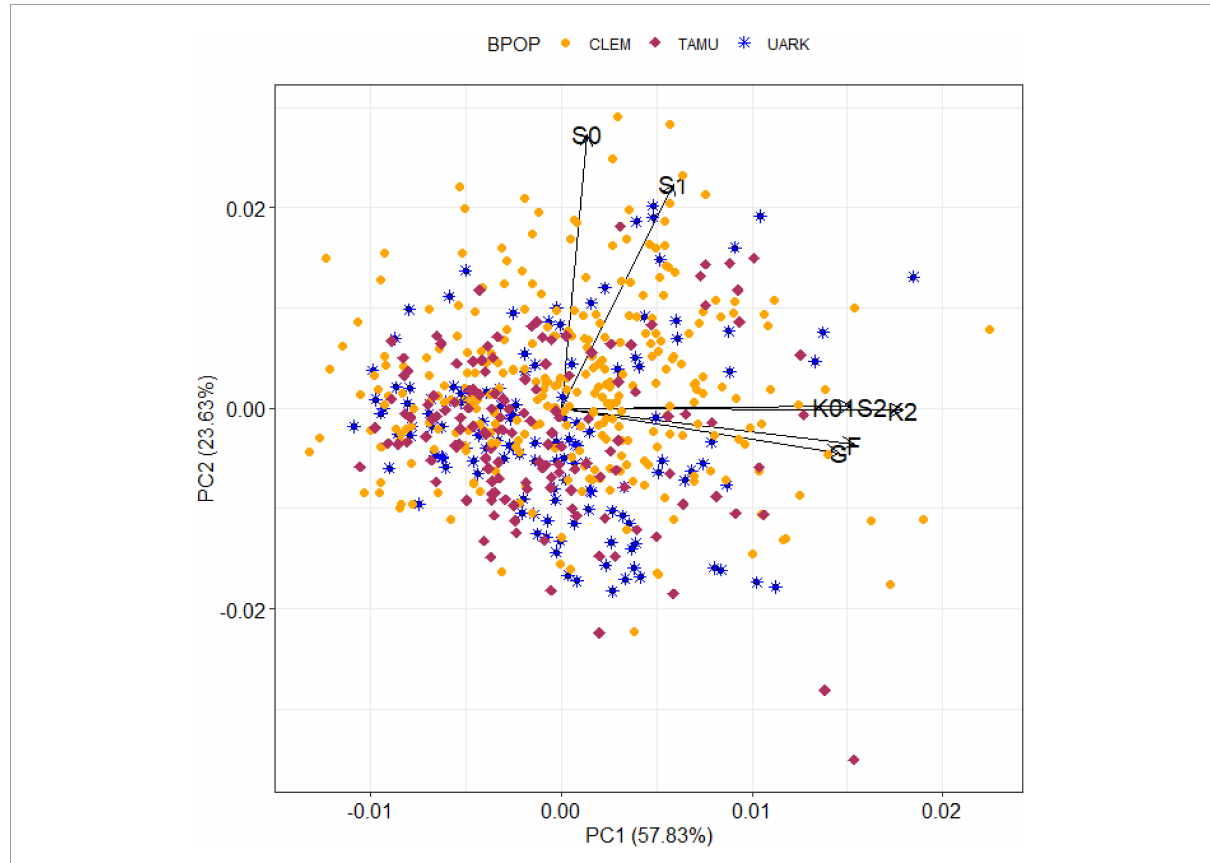
FIGURE3 A biplot of the predicted total genomic effect for SSC of peach/nectarine individuals by genomic environment (defined in Figure 2 ) from the most parsimonious QTL + background genome model